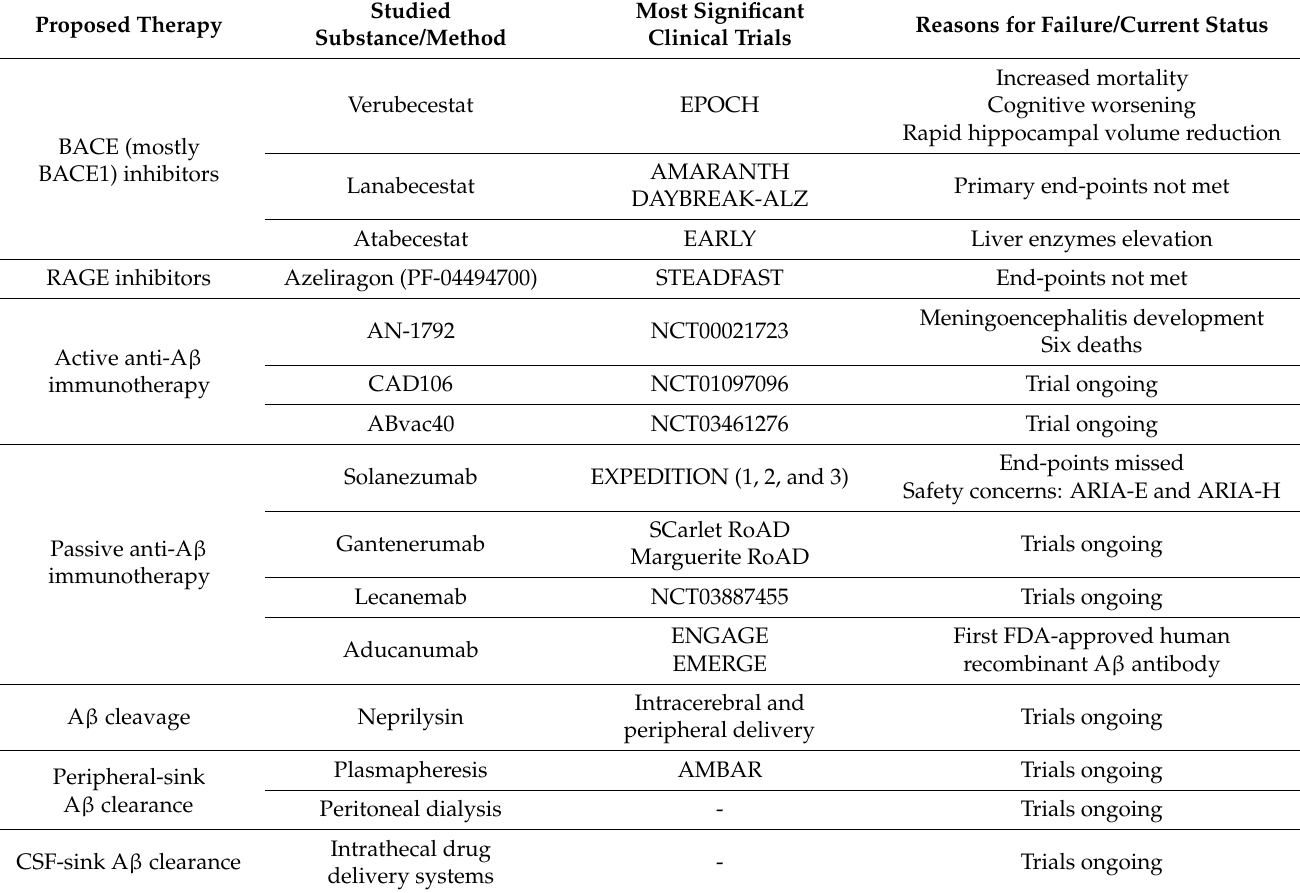
Abbreviations in Table 1: BACE, beta-site amyloid precursor protein cleaving enzyme; RAGE, advanced glycosy- lation end-product-specific receptor; FDA, Food and Drug Administration; CSF, cerebrospinal fluid; ARIA-E/H, amyloid-related imaging abnormalities